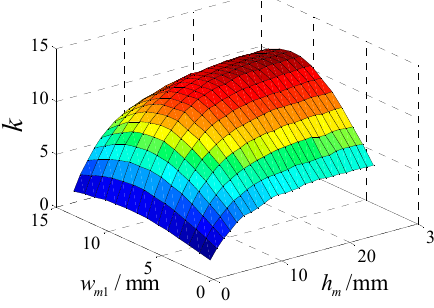
Figure 7. Force coefficient curve in terms of permanent magnet size.